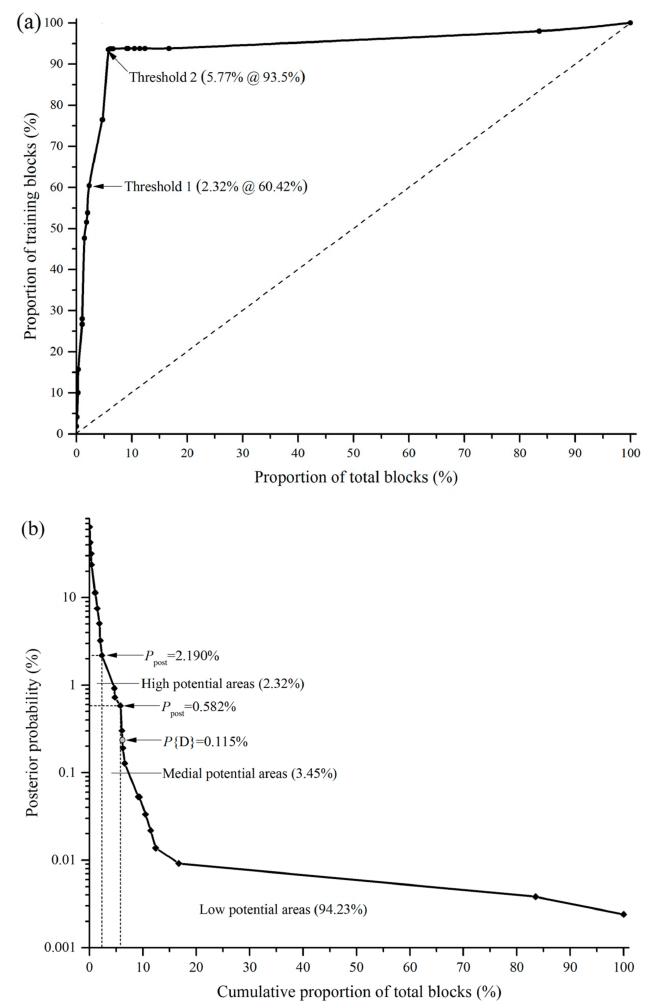
Figure 11. Curves for analysis of posterior probability, ( a ) capture-efficiency curve, showing the cumulative percentage for training blocks and total blocks, ( b ) posterior probability plotted against cumulative proportion of total